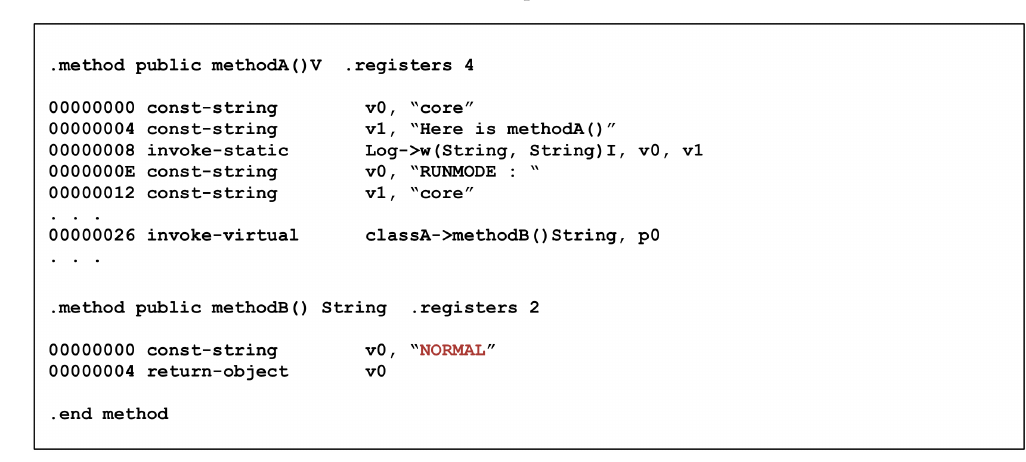
Figure 15. Sample source code.